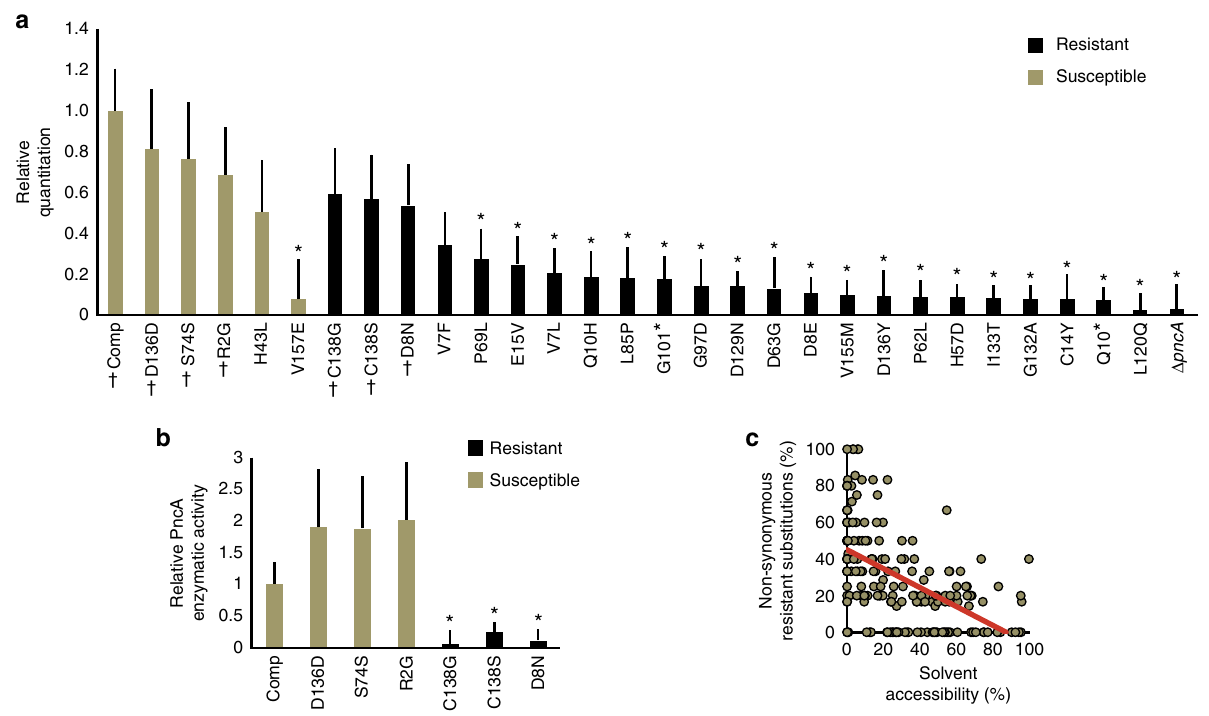
Fig. 5 PncA protein abundance and catalytic activity result in pyrazinamide resistance. a Quantitation of PncA protein abundance relative to RpoB in cataloged pyrazinamide susceptible ( brown ) and resistant ( black ) isolates determined using mass spectrometry. Protein abundance in each mutant strain is relative to the Comp strain. * P ≤ 0.01 ( t -test, two-sided). † corresponds to isolates tested for enzymatic activity. The mean fold-change of three biological replicates for each mutant relative to the mean of 10 biological replicates for Comp is shown. Errors bars represent the standard deviations derived from the propagation of error using the quotient of the coef fi cient of variation. b Mean PncA catalytic activity relative to the Comp strain is shown. * P ≤ 0.05 ( t -test, two-sided). Error bars represent the standard deviations derived from three biological replicates for each strain by the propagation of error using the quotient of the coef fi cient of variation. c Correlation between the solvent accessibility (%) and the proportion (%) of all possible non-synonymous amino acid substitutions that confer pyrazinamide resistance at each amino acid in PncA. Linear trend line is shown in red ( r = −